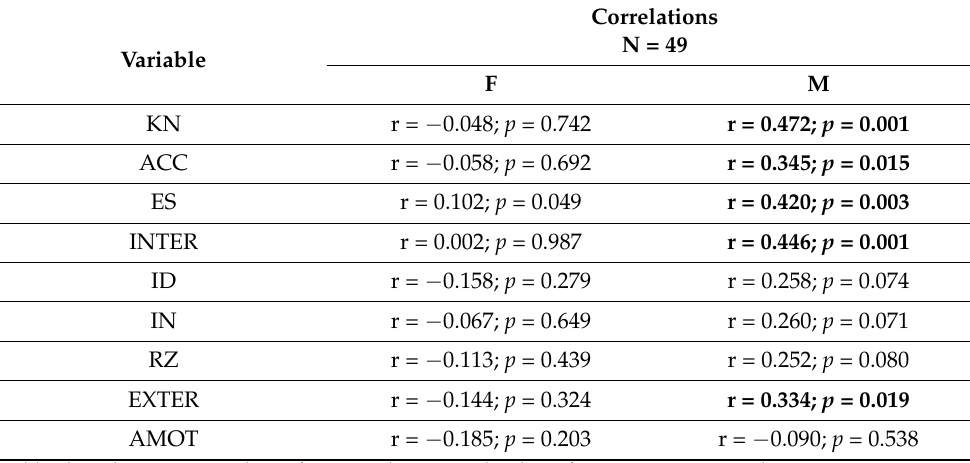
Table 1. Relationships between the levels of psychological femininity and masculinity and dimensions of motivation in the group of women (women athletes) training in team sports games studied— Pearson’s r correlation